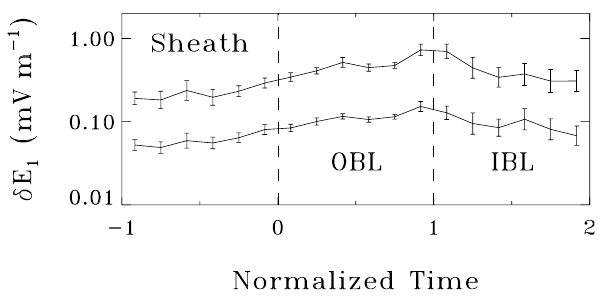
Fig. 10. Superposed epoch analysis of the root-mean-square ampli- tudes of electric fluctuations in the range of 25–800Hz, δE 1 and δ ˆ E 1 , across the outer boundary